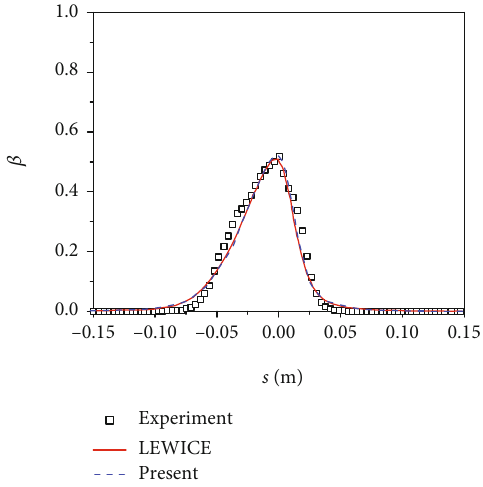
Figure 7: Comparison of collection e ffi ciency with experimental and LEWICE results for the MS (1)-0317 airfoil.